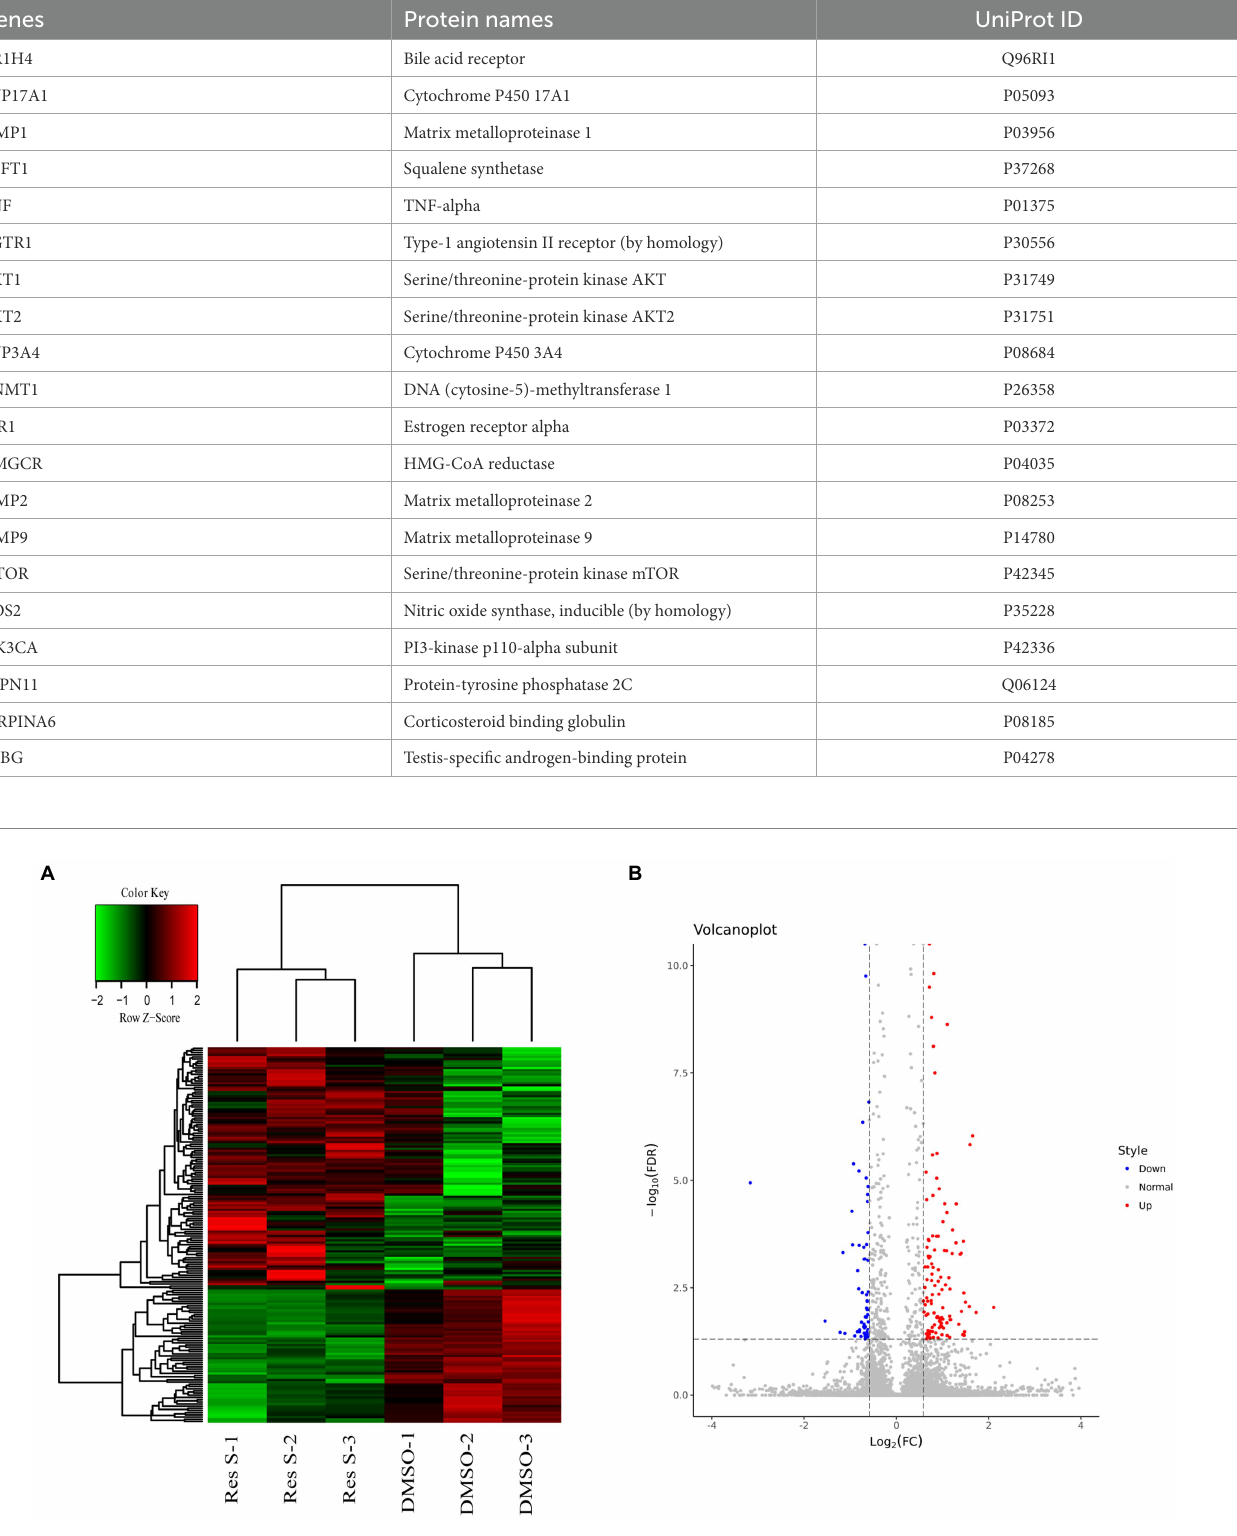
correlated with the degree of liver fibrosis (18). AKT Serine/Threonine Kinase 1 (AKT1) is a serine/threonine protein kinase, which is called an important downstream target signal pathway of insulin and has